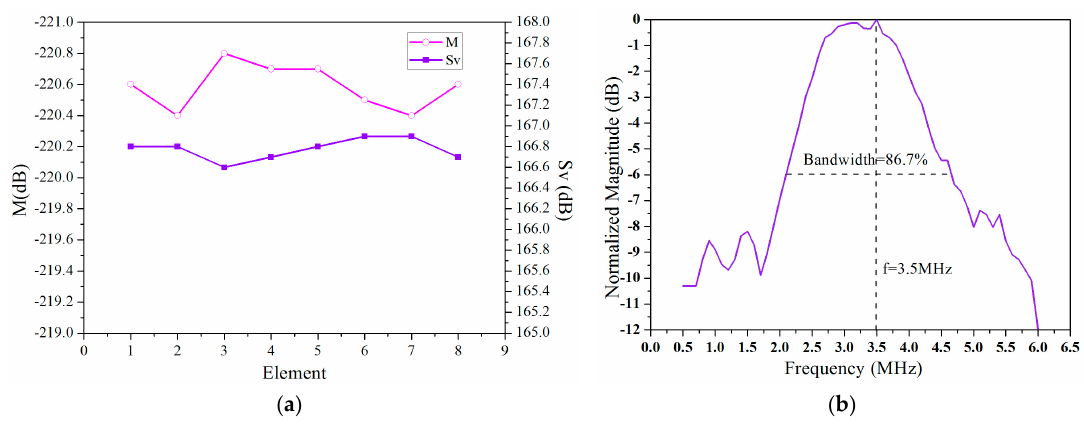
Figure 3. Frequency property of the ultrasound transducer. ( a ) Sensitivity. ( b ) Fractional bandwidth.